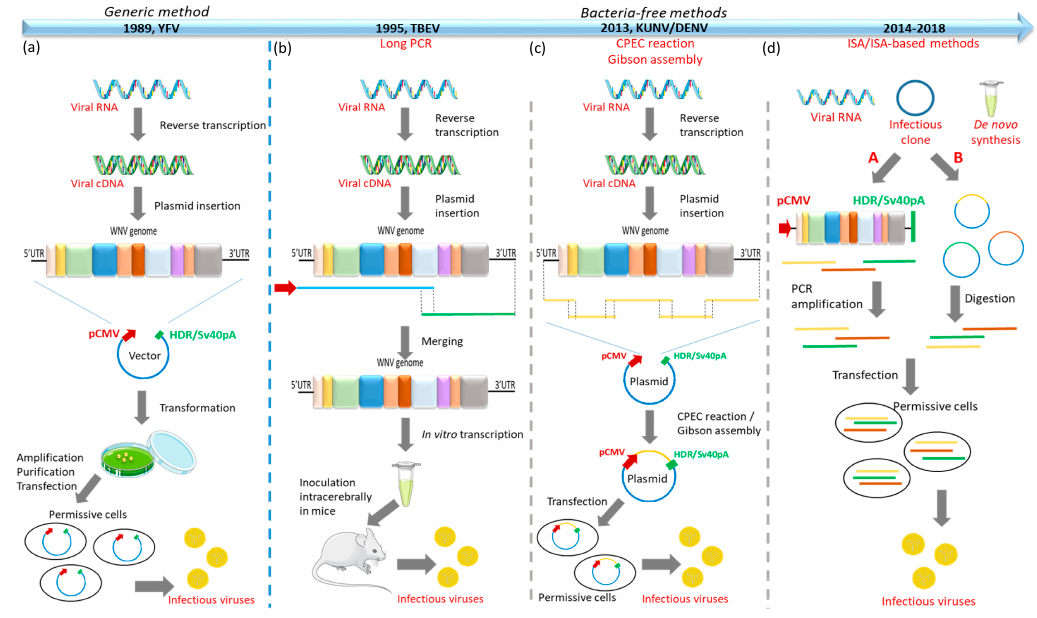
Figure 5. Overview of the main reverse genetic methods. ( a ) First generic method for reverse genetics developed in 1989 for YFV. cDNA was produced from viral single-stranded RNA, and then inserted into a plasmid upstream of a pCMV promoter and downstream of the hepatitis delta ribozyme, followed by the simian virus 40 polyadenylation signal (HDR / SV40(pA)) sequence. After amplification